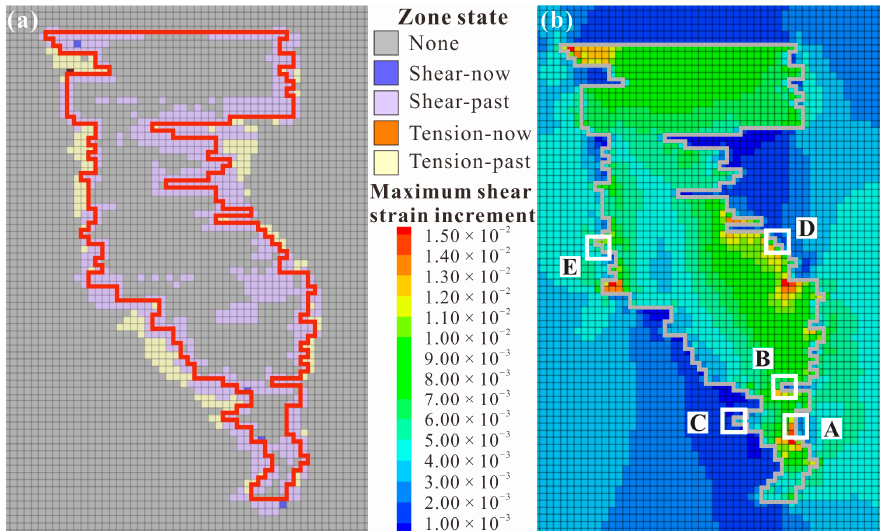
Figure 6. Numerical simulation results. ( a ) Plastic zone; ( b ) maximum shear strain increment. (A) Linear model; (B) Embedded model with the filling body enclosed by surrounding rock; (C) Embedded model with the surrounding rock enclosed by filling body; (D) Multiple broken line model with the backfill located in the footwall; (E) Multiple broken line model with the surrounding rock located in the footwall.